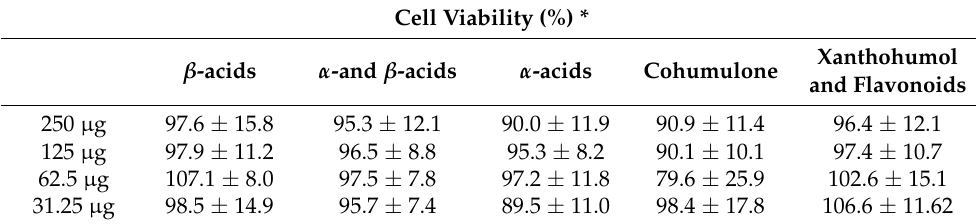
Table 1. Cell toxicity of hops compounds in Vero cell